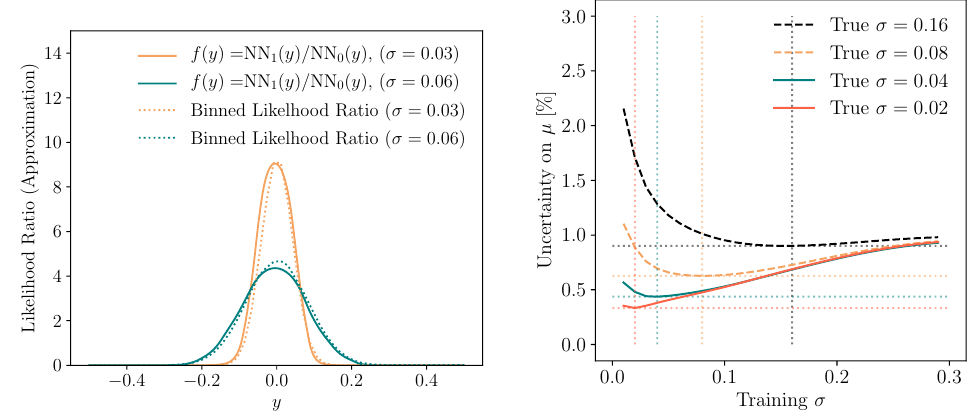
Figure 7: Left: The functional form of f σ ( y ) alongside a binned version of the like- lihood ratio for values of σ not presented to the neural network during training: σ ∈ { 0.03,0.06 } . Right: The statistical uncertainty on the value of µ when perform- ing a statistical test with f σ (cid:48) ( y ) where σ (cid:48) is the value of the nuisance parameter used in the training. The true value of σ (the one used in testing) is indicated by vertical dashed lines. This test used | Y | = 10 4